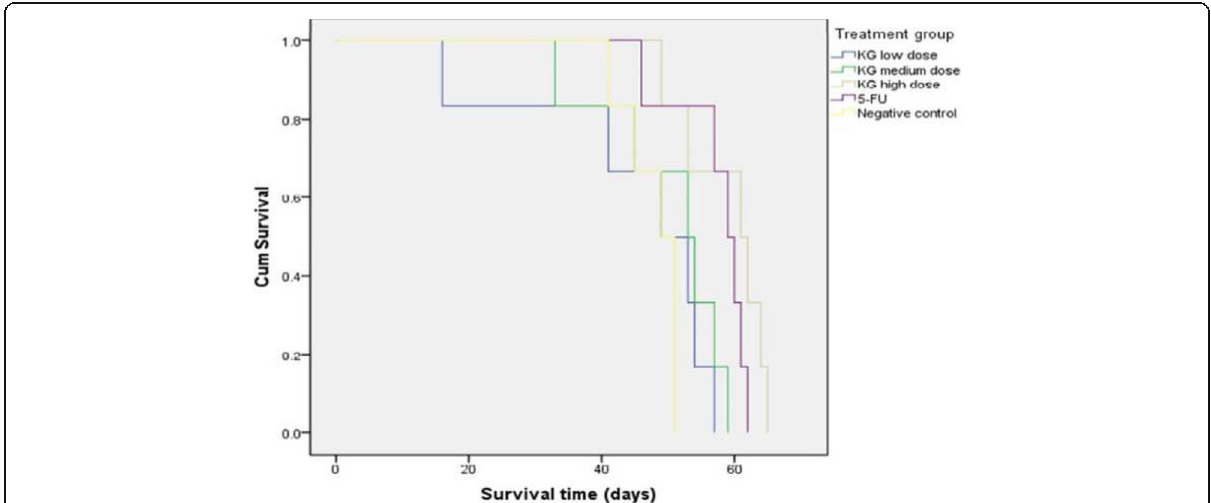
Fig. 3 Median survival time (days) of CCA-xenografted nude mice receiving the three dose levels of K. galanga Linn, i.e., high (1000 mg/kg body weight), medium (500 mg/kg body weight) and low (100 mg/kg body weight), and reference drug (5-FU) during the observation period (3 male and 3 female mice for each group). Abbreviations: KG = K. galanga l Linn., 5-FU =